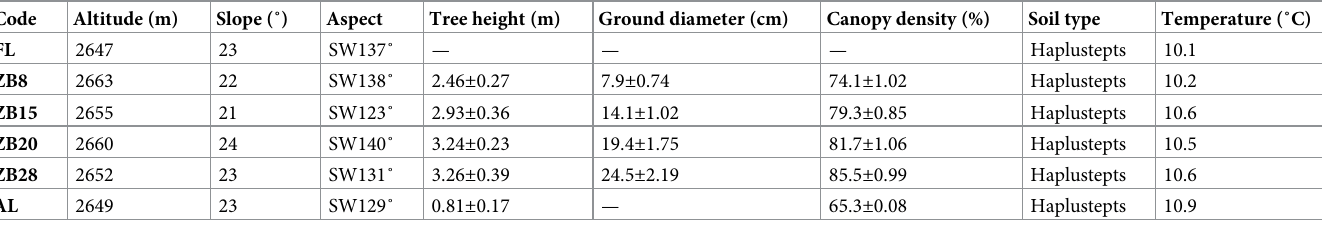
Table 1. Geographical and plant community characteristics of farmland conversion sites in Arid Valley.